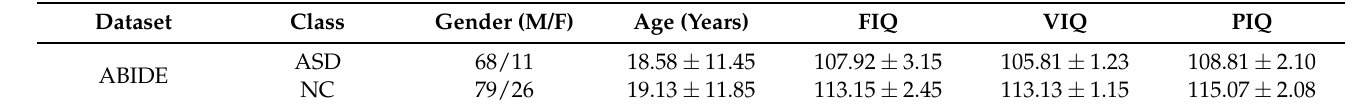
Table 1. Demographic and clinical information of subjects at the NYU site from the ABIDE dataset [38]. Values are reported as mean ± standard deviation. M/F: male/female; MMSE: Mini-Mental Exami- nation; GCDR: Global Clinical Dementia Rating; FIQ: Full-Scale Intelligence Quotient; VIQ: Verbal Intelligence Quotient; PIQ: Performance Intelligence